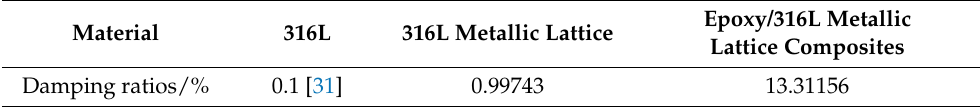
Table 1. Damping properties of fabricated 316L metallic lattice structure and the epoxy/316 metallic lattice composites. Material 316L 316L Metallic